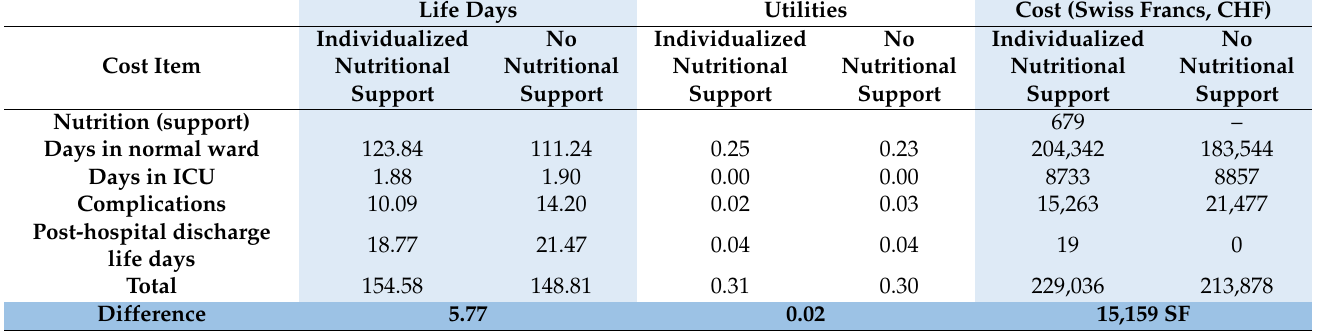
Table 2. Costs and cost differences by nutrition group over 180 days for HF patients in the EF- FORT trial. Life Days Utilities Cost (Swiss Francs, CHF)